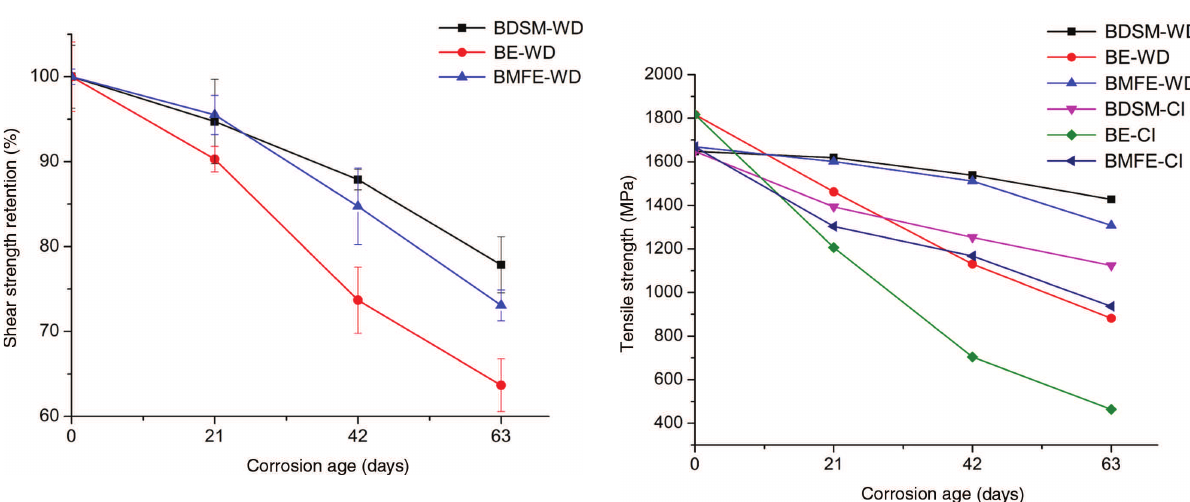
Figure 9: Shear strength retention.